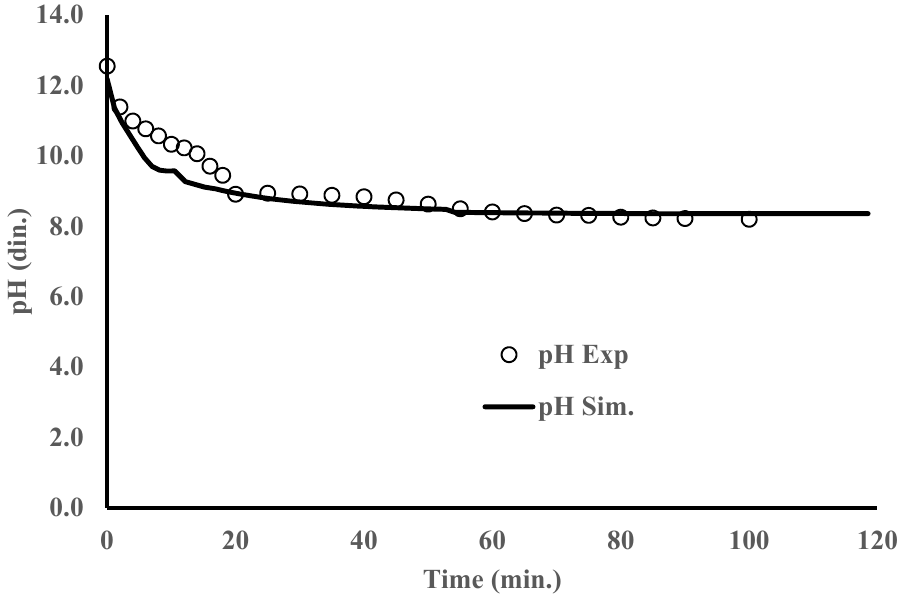
Figure 7. Comparison of the time variation of pH for experimental data and simulation results.